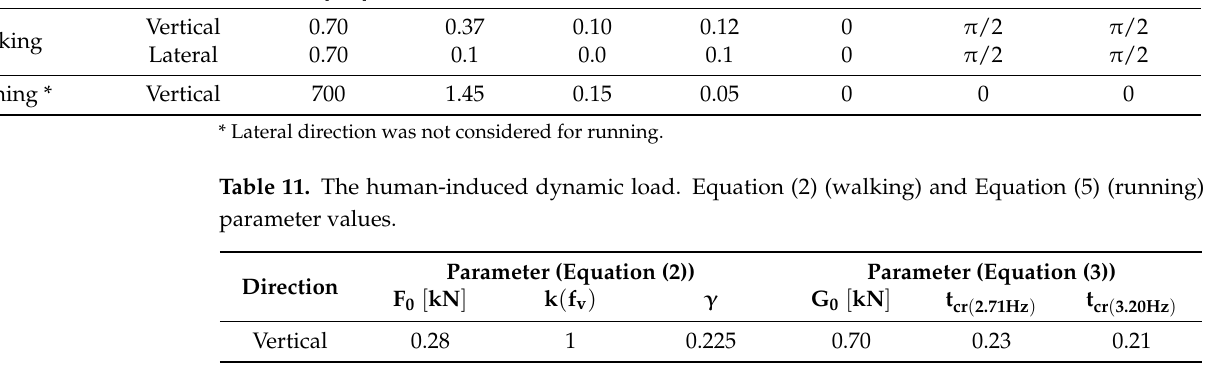
Table 10. The human-induced dynamic load (walking and running). Equations (2) and (3) parameter values. Parameter (Equations (2) and (3)) Type of Motion Direction Vertical Walking